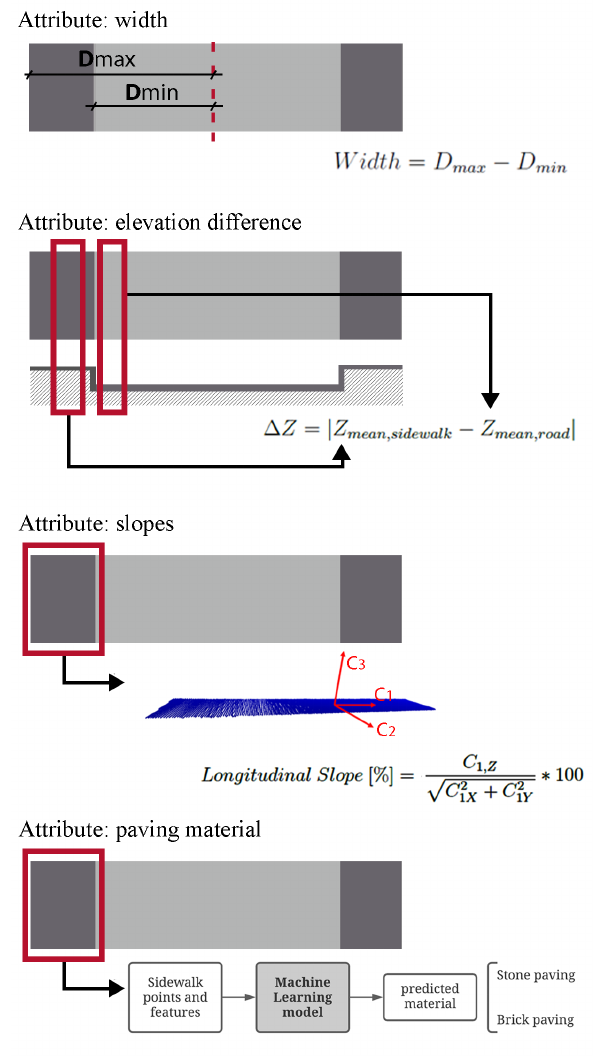
Figure 2. Explanation of all the sidewalk geometric attributes extracted from the point cloud and how they were